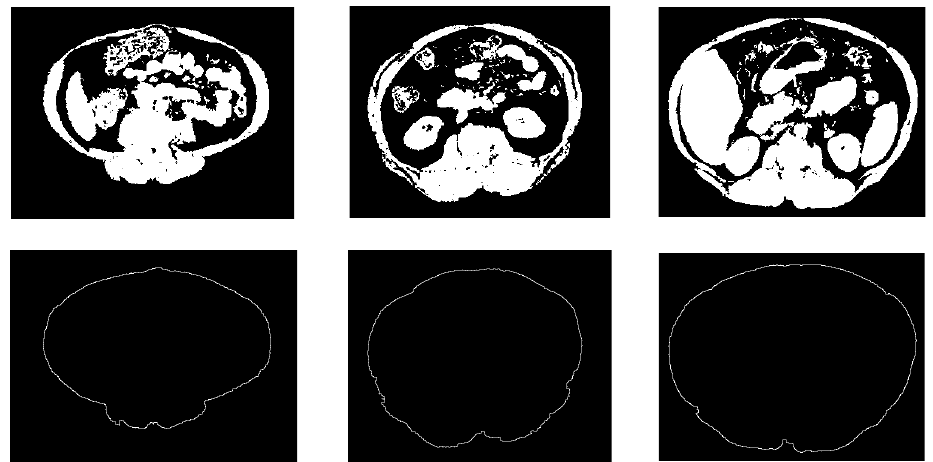
Figure 7. Samples from the abdomen wall boundary detection results. The top row is the non-fat binary images, the bottom row is the abdomen wall boundary images.